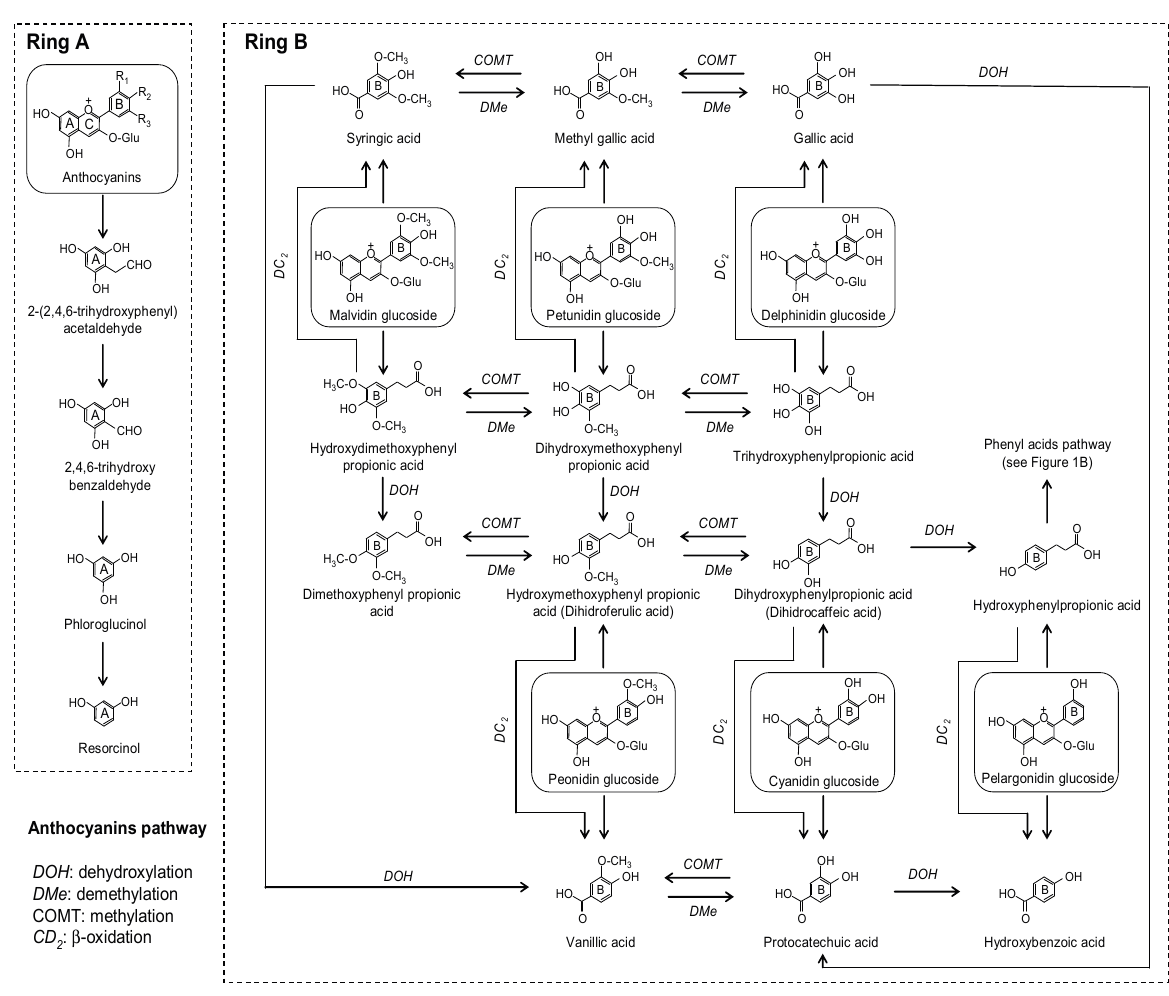
Figure 5. Proposed colonic pathways of